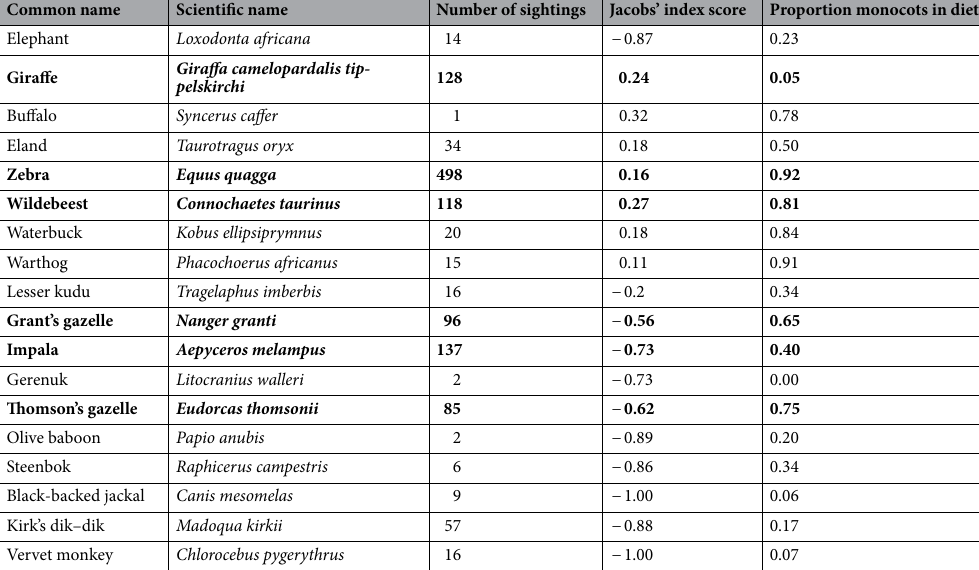
Table 1. Common and scientific names, as well as number of occurrences (N = 1254) of large mammal species observed in Manyara Ranch, Tanzania, listed in descending order of body mass. For each species, we also include the Jacobs’ index which quantifies the prey preference (positive values) or avoidance (negative values) by lions 68 , and the percentage of monocot consumption 28,69–73 . For the six most abundant species (highlighted in bold), we conducted species-specific